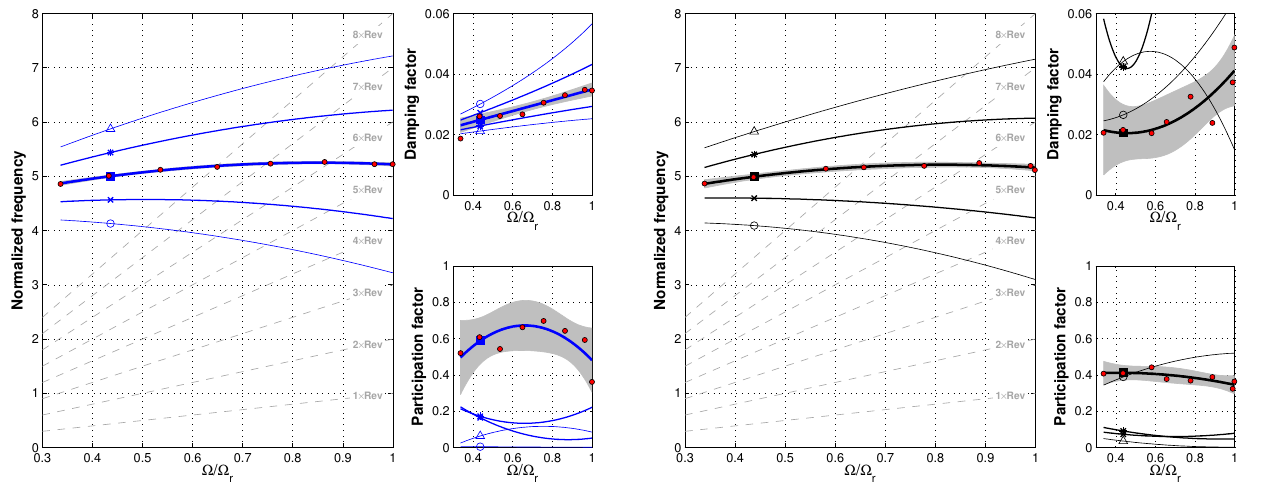
Figure 11. Periodic Campbell diagram of the forward whirling in-plane mode obtained from PARMAX (left) and POMA (right) identifica-